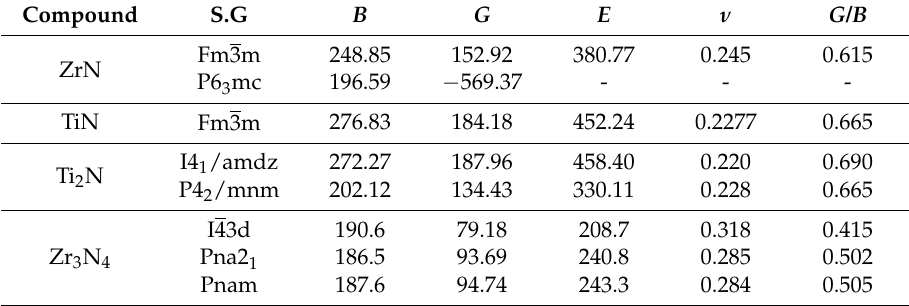
Table 6. Bulk modulus B (GPa), Shear modulus G (GPa), Young’s modulus E (GPa), Poisson’s ratio ν and G / B of ZrN, Zr 3 N 4 , TiN and Ti 2